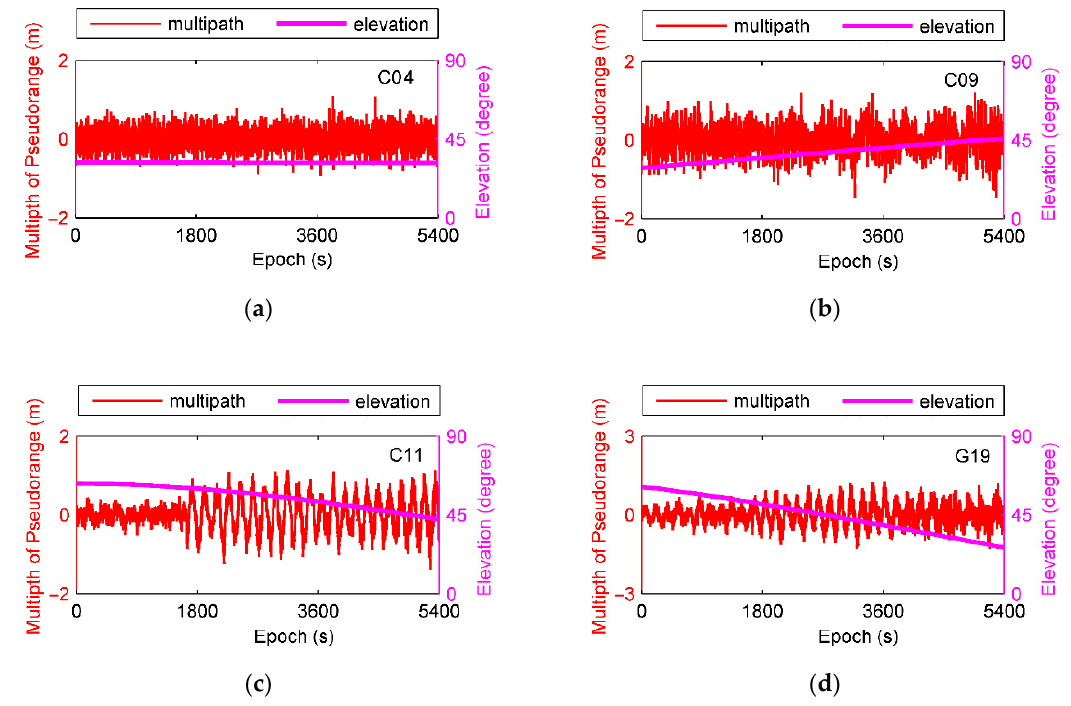
Figure 3. Code multipath and satellite elevations, ( a ) is for C04, ( b ) is for C09, ( c ) is for C11, and ( d ) is for G19. From indicated results, C04 is a GEO satellite moving to and fro gradually, and C09 is an IGSO satellite rising from the southeast. C11 and G19 are MEO satellites sinking